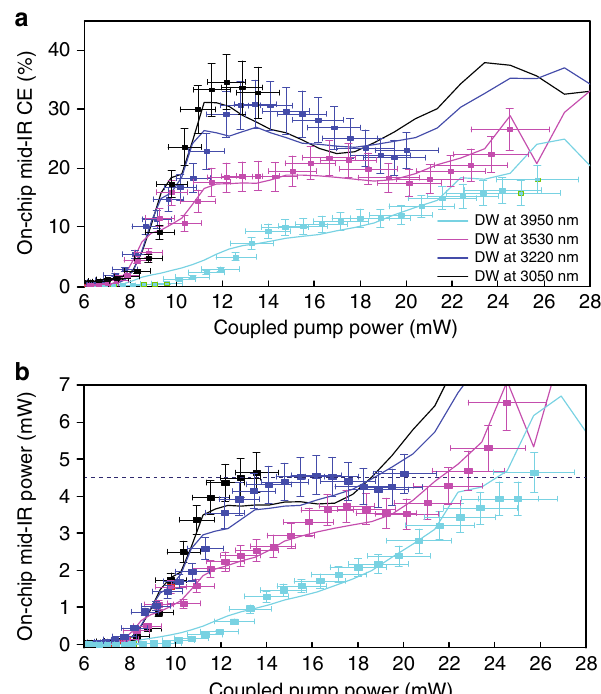
Fig. 4 Dispersive wave ef fi ciency. Scattered points represent experimental data, lines are simulations. a mid-IR DW generation on-chip conversion ef fi ciency (CE) as a function of coupled pump power. Error bars of ±0.5 dBm and ±0.25 dBm represent the standard deviation of repeated measurements of DW and coupled pump powers, respectively. b On-chip mid-IR DW power estimated from measured spectra. Error bars: same as for ( a ). 4.5 mW of on-chip DW power is reached at 3050 nm with 13 mW pump power, at 3220 nm with 16 mW of pump power, at 3530 nm with 22 mW of pump power, and 3950 nm with 26 mW of pump